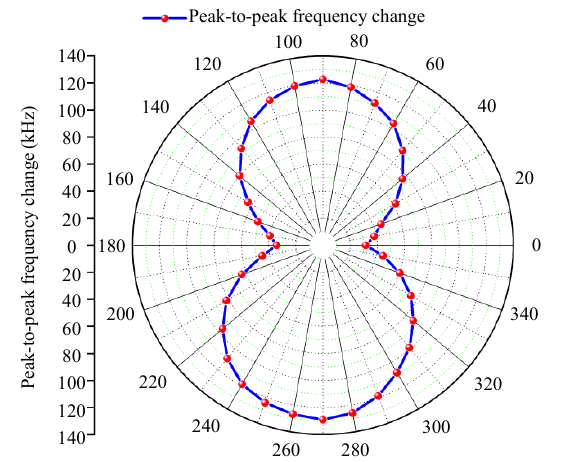
Fig. 6 Beat frequency variation amplitudes for various rotation angles of the sensor. The current is alternating at 12 kHz with peak-to-peak amplitude of 1 A and the magnetic flux density is 3